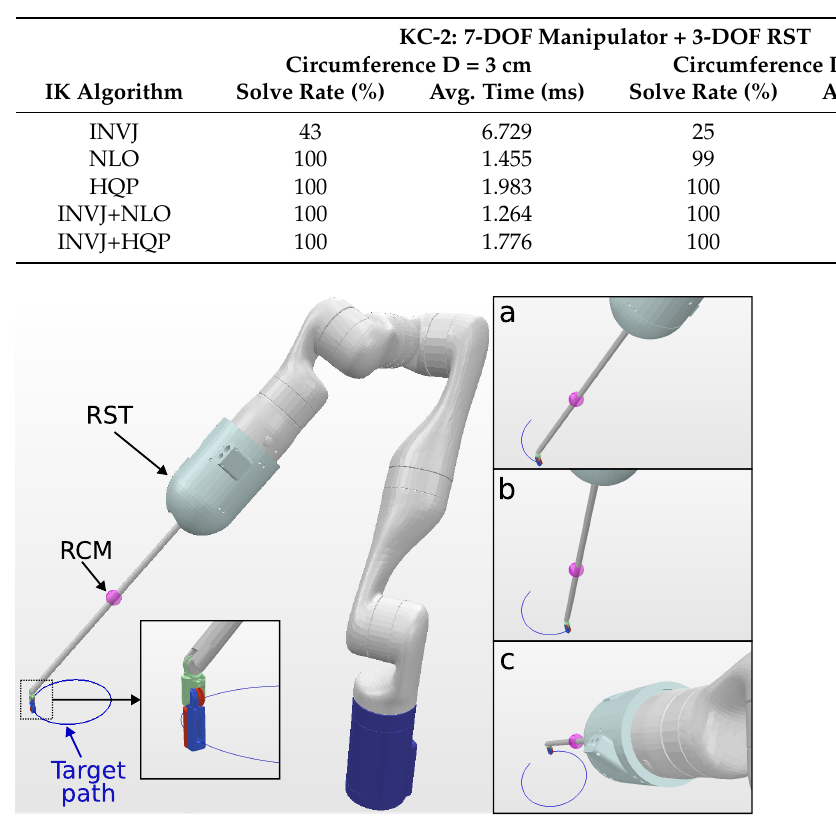
Figure 6. Simulation environment for KC-2 Kinematic chain (OpenRST) tracking a 10 cm circular path. In the close-up view, the tool tip target orientation is shown. The trajectory followed by the surgical tool tip is visualized in blue, and snapshots ( a – c ), shown on the right, depict the robot executing the tracking task at different trajectory